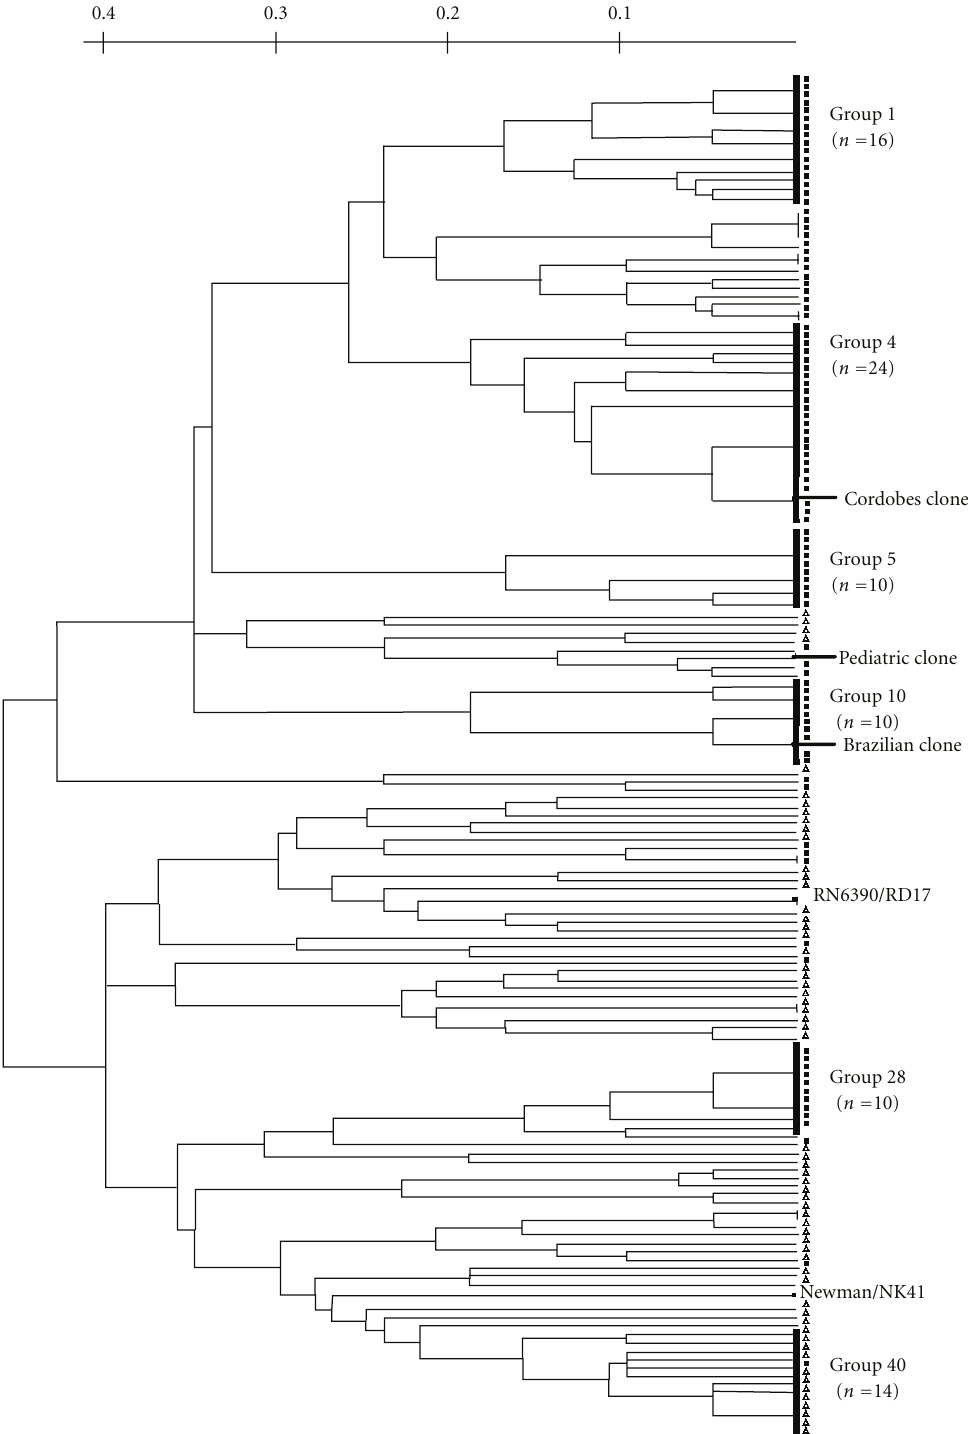
Figure 2: Dendrogram of S. aureus attenuated mutants (RD17 and NK41), their parental (RN6390 and Newman) strains, and S. aureus nasal colonizing ( Δ ) and osteomyelitis ( (cid:3) ) ( n = 159) isolates. Sma I PFGE typing discriminated 40 di ff erent pulsotypes. The major groups were named 1, 4, 5, 10, 28, and 40. S. aureus strains representative of Cordobes, Pediatric, and Brazilian clones are indicated